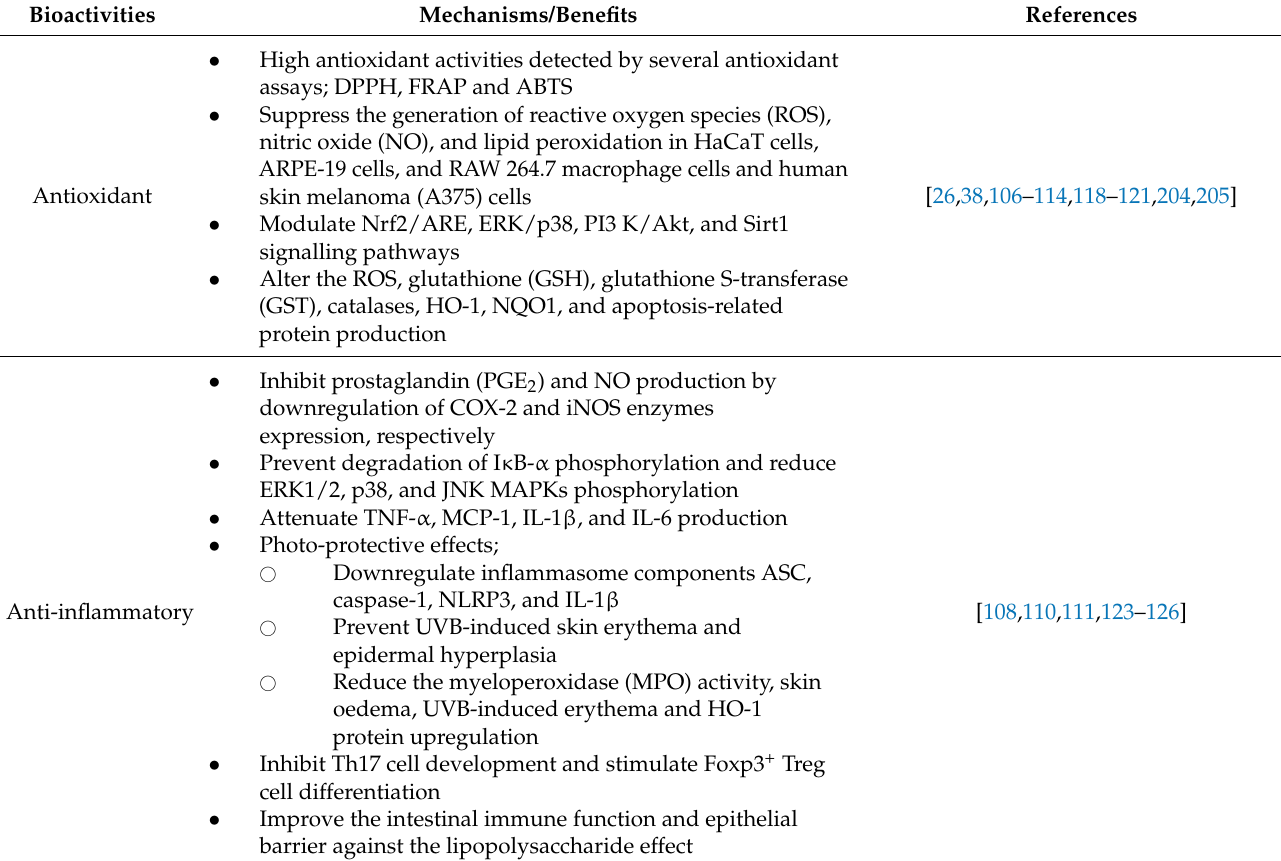
Table 2. Summary of fucoxanthin’s biological activities and its beneficial